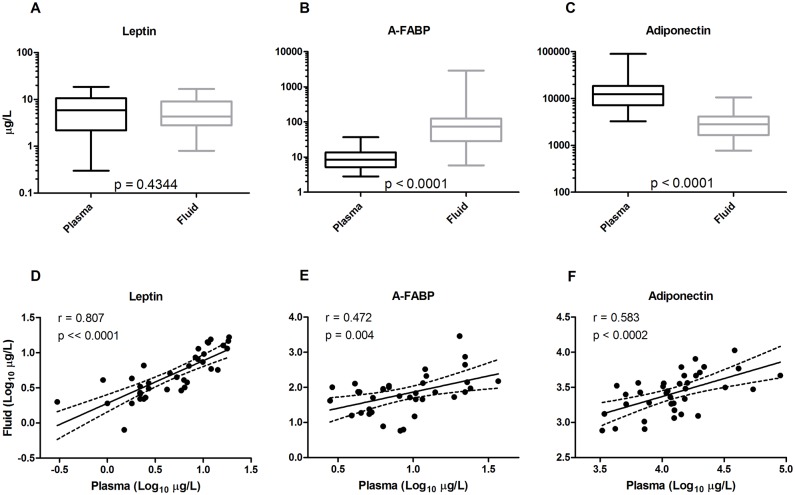
Venous plasma and pericardial fluid concentrations of leptin (left), adipocyte fatty acid-binding protein (A-FABP, middle) and adiponectin (right) in cardiac and vascular disease patients (n = 36–37).Top, box plots illustrating median values, interquartile range and range of concentrations compared by Wilcoxon matched-pairs signed rank test. Bottom, double logarithmic plots by Pearson’s correlation illustrating the relationship between pericardial fluid concentrations and circulating levels of the adipokines.